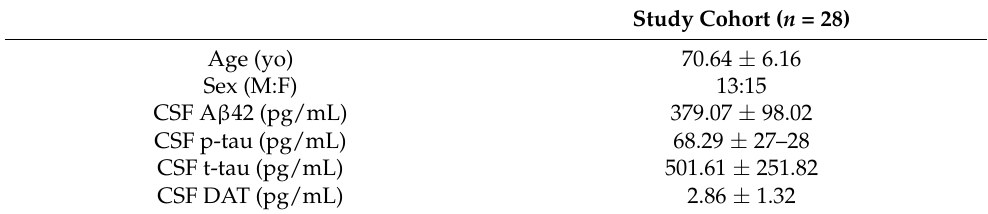
Table 2. Demographic data from the study